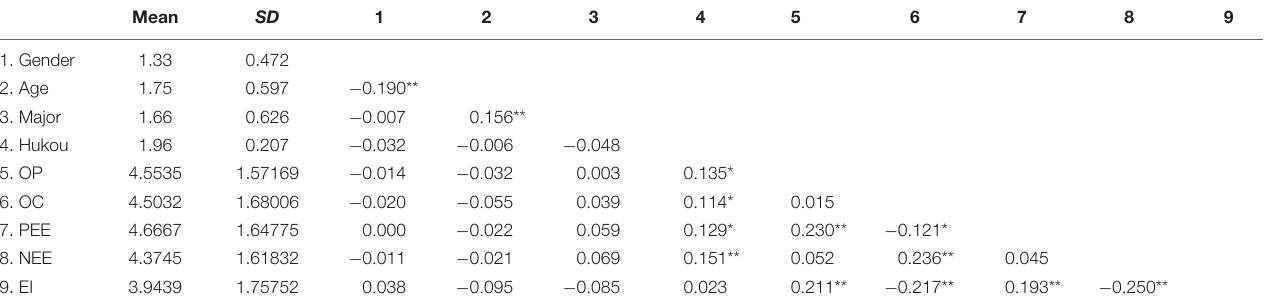
TABLE 1 | Descriptives and correlations.